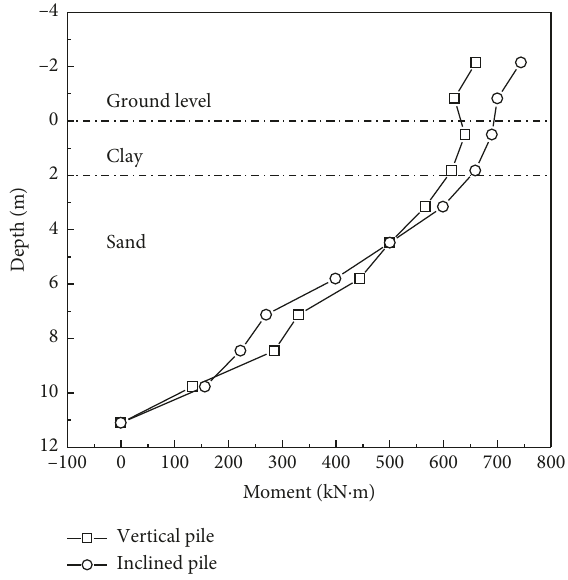
Figure 16: Moment envelope diagram of